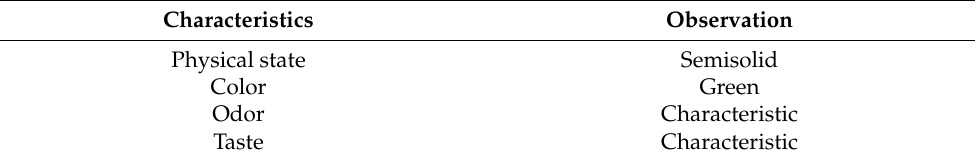
Table 1. Evaluation of organoleptic characteristics of the extract.